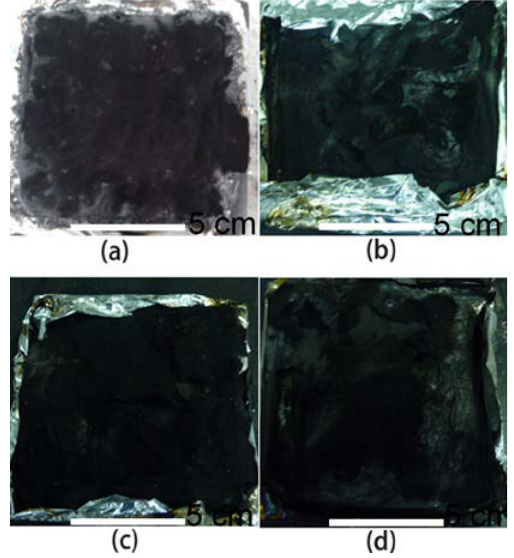
Figure 6. Digital photographs of the residues after cone calorimeter tests. ( a ) ELDH - 0; ( b ) ELDH - Ni; ( c ) ELDH - Co; ( d ) ELDH - Cu.